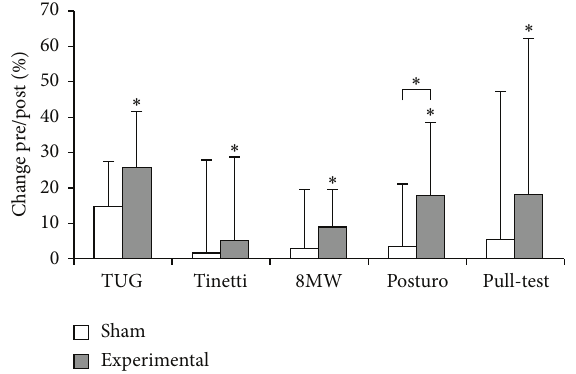
Figure2:Change(%)ofmotorscorescomparingpre-andposttreat- ment values. Within-group comparison demonstrated significant improvement in the experimental group (asterisks) but not in the shamgroup.Between-groupanalysiscomparingchangeofshamand experimental group was significant for posturography only (asterisk over